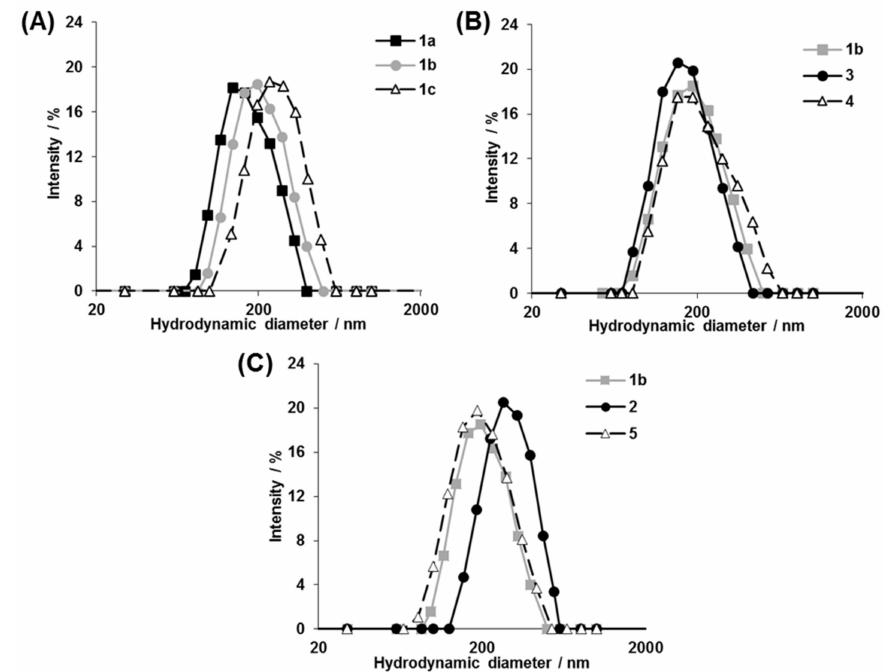
Figure 3. Dynamic light scattering (DLS) characterization of photoresponsive polymersomes. ( A